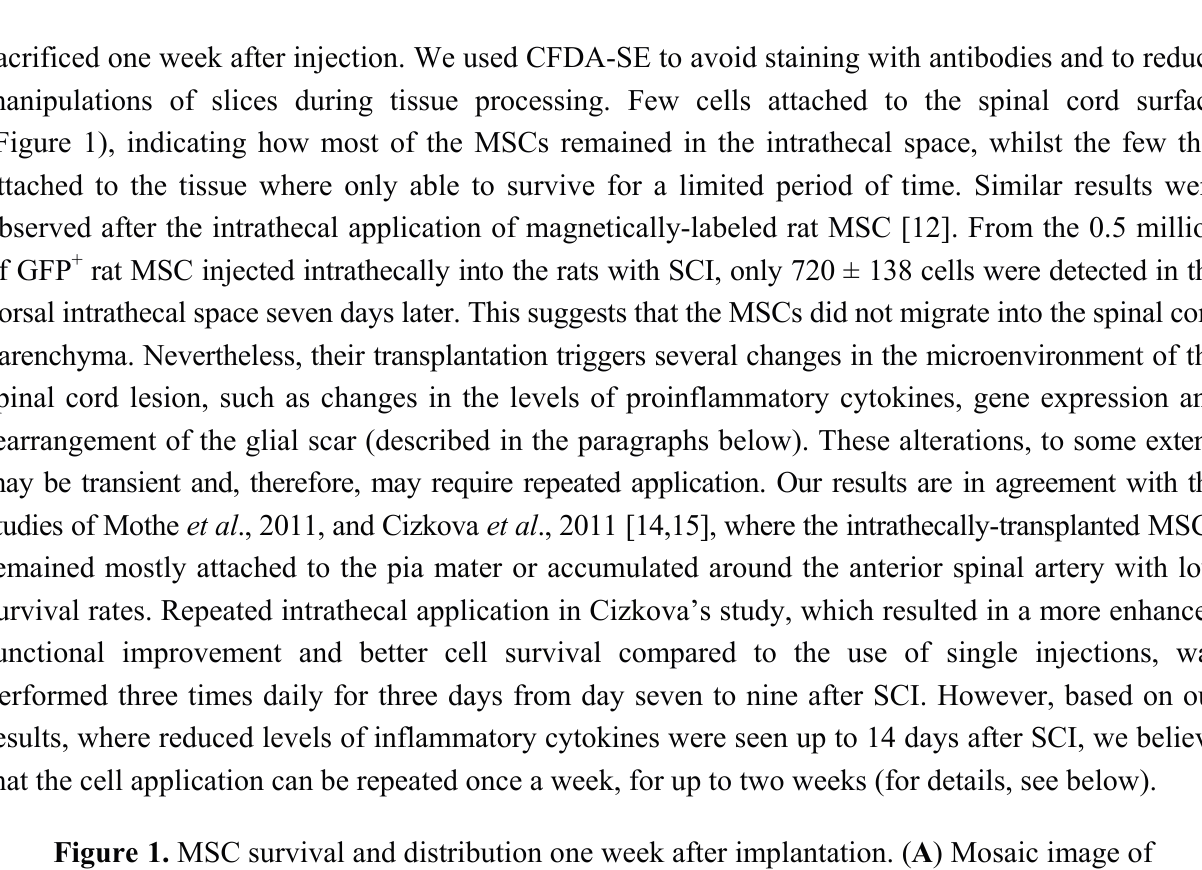
a longitudinal sectioned spinal cord with carboxy-fluorescein diacetate succinimidyl ester (CFDA-SE) labelled MSCs on the dorsal surface; ( B – D ) Cells attached to the spinal cord surface. Scale bars ( A ) 500 µm, ( B – D ) 100